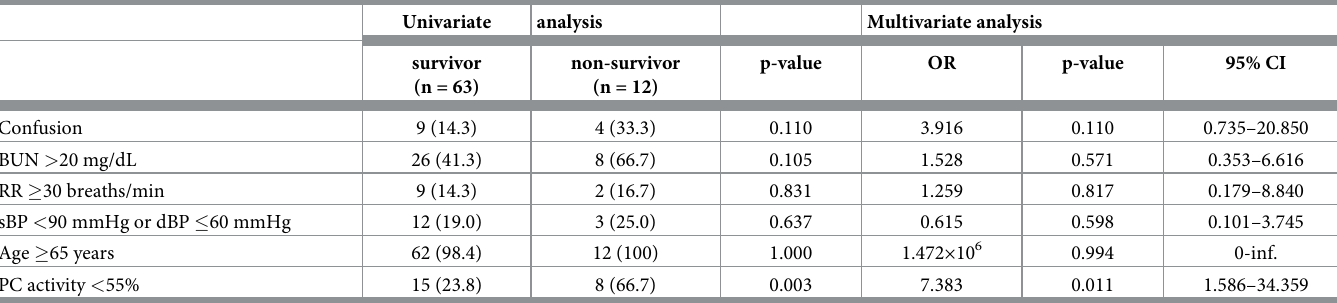
Table 4. Examination of prognostic factors using logistic analysis in NHAP.